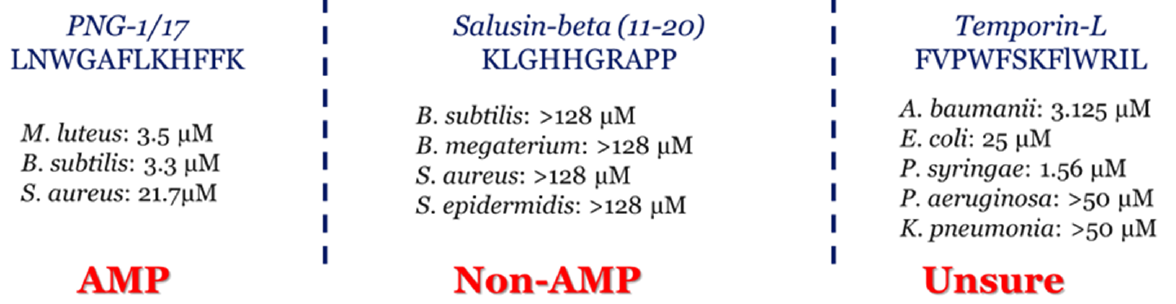
Figure 10. Different examples of peptides with their reported experimental activities and their label.